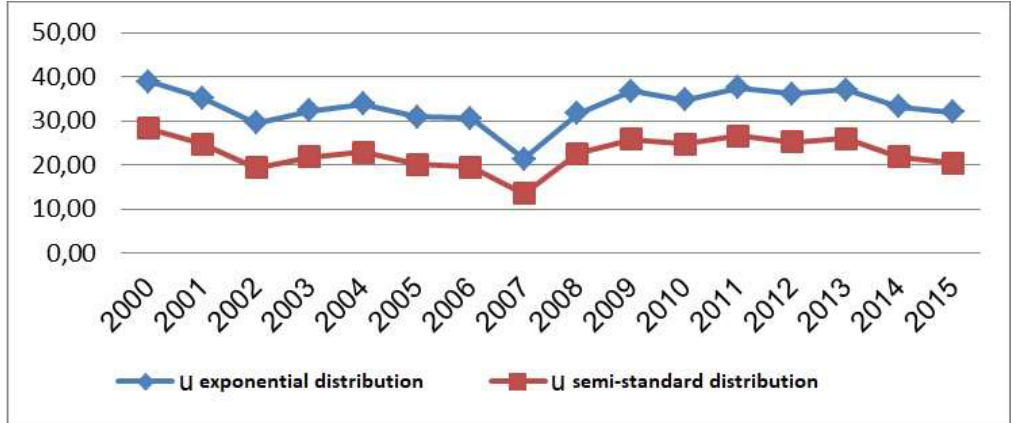
Figure 1. Exploiting the potential of rice exports in the period of